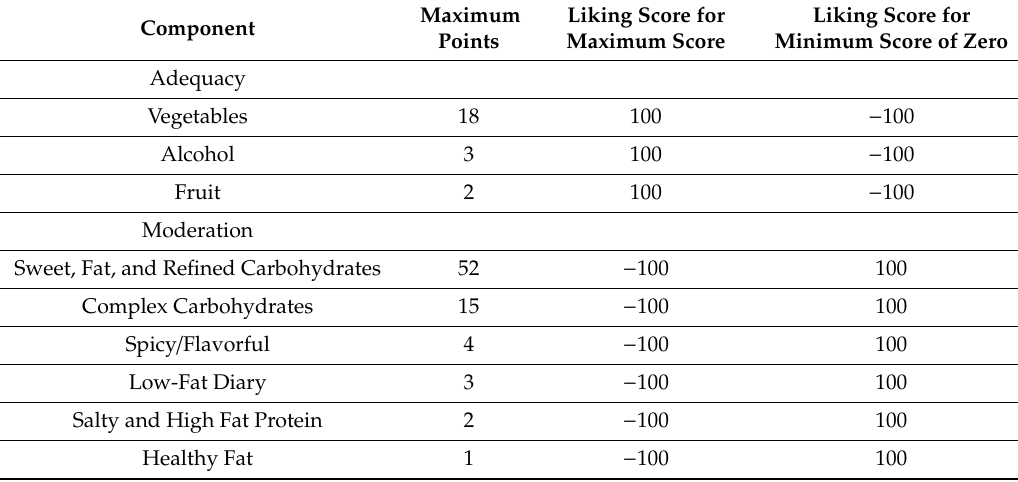
Table 4. Food groups generated from a liking score in young adults that formed the Hybrid Diet Quality Index (DQI) listed as those associating with better (adequacy) and worse (moderation) cardiometabolic risk factor score (CRFS). Food groups were weighted according to strength of the association with the CRFS to achieve a 0 to 100-point score. Maximum Liking Score for Liking Score for Component Points Maximum Score Minimum Score of Zero Adequacy Vegetables 18 100 − 100 Alcohol 3 100 − 100 Fruit 2 100 − 100 Moderation Sweet, Fat, and Refined Carbohydrates 52 − 100 100 − 100 4 − 100 100 3 − 100 2 − 100 100 Healthy Fat 1 − 100